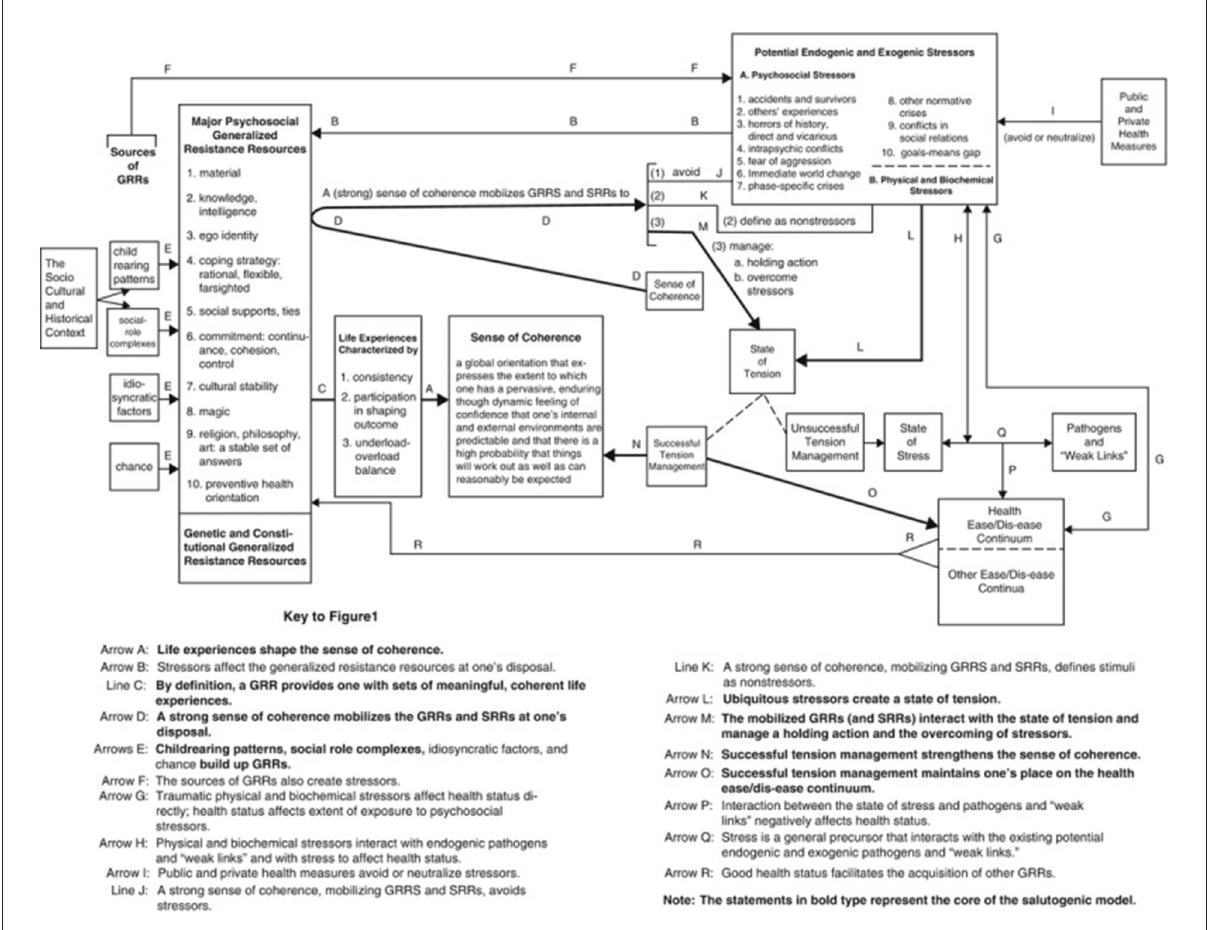
FIGURE2 Antonovsky’s salutogenic model of health (Mittelmark et al.,